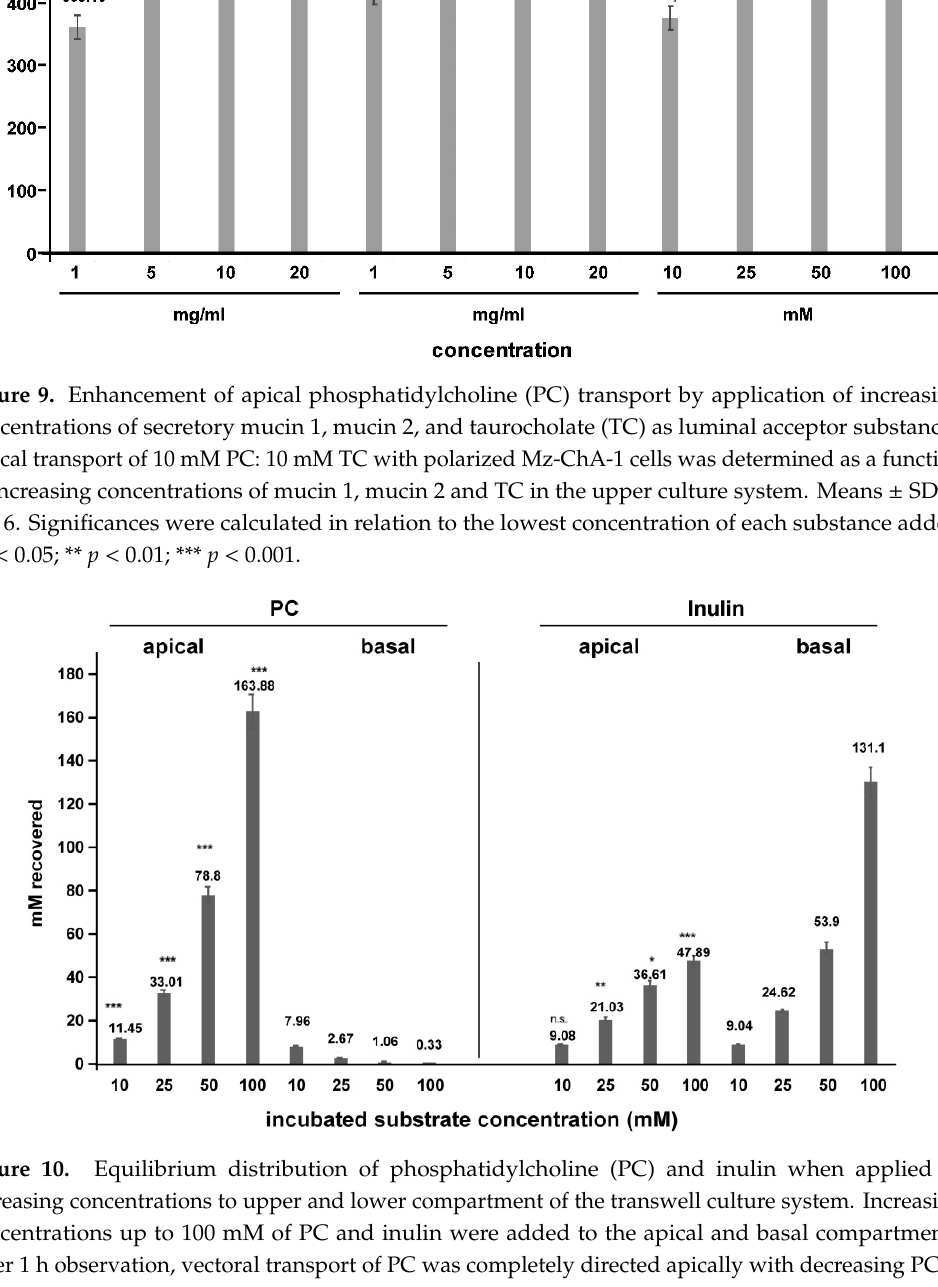
Figure 10. Equilibrium distribution of phosphatidylcholine (PC) and inulin when applied in increasing concentrations to upper and lower compartment of the transwell culture system. Increasing concentrations up to 100 mM of PC and inulin were added to the apical and basal compartments. Over 1 h observation, vectoral transport of PC was completely directed apically with decreasing PC at the luminal side (less than 1%). For inulin there was a significantly higher basal accumulation starting at 25 mM incubated. The process appeared to be less e ff ective, at least at lower concentrations, as for the transport of PC to the apical side. Means ± SD of n = 6. Significances were calculated for apical versus basal transport for each in relation to the lowest concentration of each substrate concentration. n.s. = not significant; * p < 0.05; ** p < 0.01; *** p <